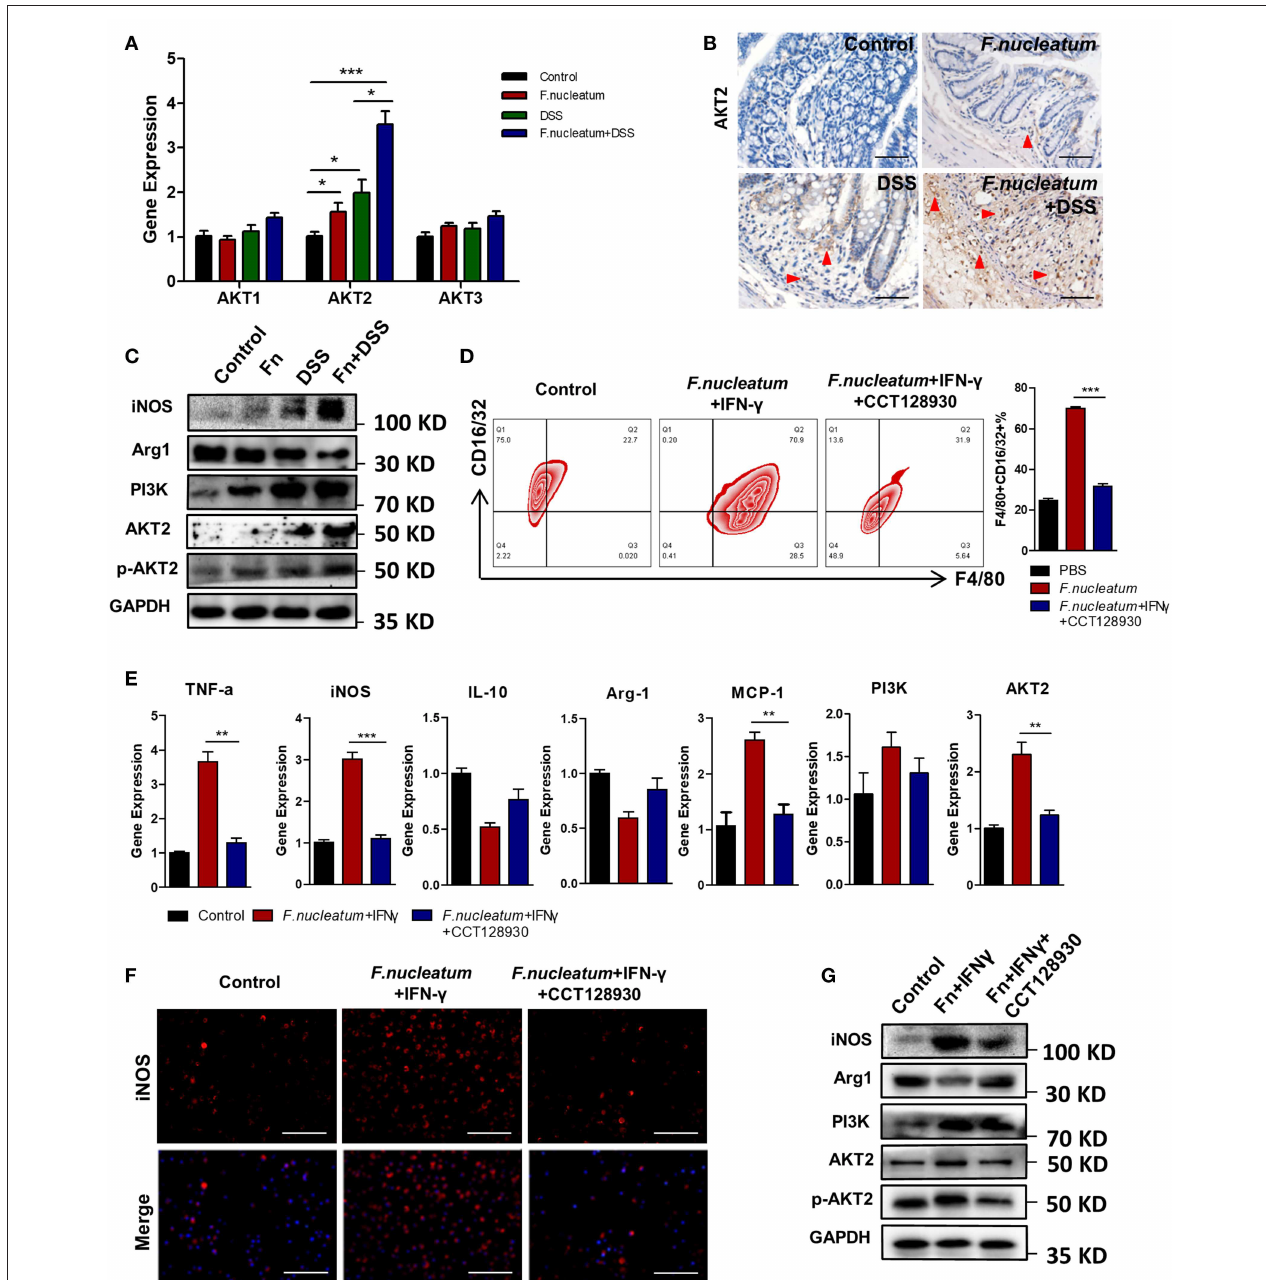
FIGURE 5 | F. nucleatum promotes M1 polarization via AKT2 signaling. (A) AKT1, AKT2, and AKT3 expression measured by qRT-PCR. (B) Representative colon images of AKT2 IHC staining. Representative images are shown. Scale bars, 25 µ m. (C) iNOS, Arg1, PI3K, AKT2, phospho-AKT2, and GAPDH levels measured by Western blot. (D) BMDMs F4/80 and CD16/32 staining by flow cytometry. Ratio of F4/80 and CD16/32 double positive cells were performed. (E) M1 markers, TNF- α and iNOS; M2 markers, IL-10; and Arg-1, as detected by qRT-PCR. (F) BMDMs were immunostained with iNOS (red) and DAPI (blue) from each group. Representative images are shown. Scale bars, 50 µ m. (G) iNOS, Arg1, PI3K, AKT2, phospho-AKT2, and GAPDH as measured by Western blot. Each experiment was performed at least three times. Data are presented as means ± SD. * P < 0.05; ** P < 0.01; *** P < 0.001; Analysis of Variance (ANOVA) and Student’s t -test (two-tailed).